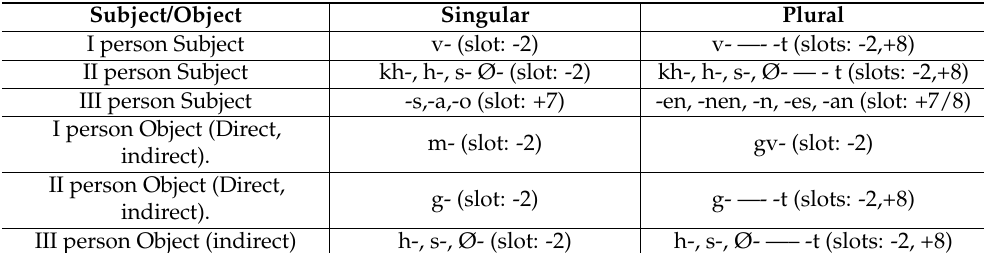
Table 4. Verbal person markers in